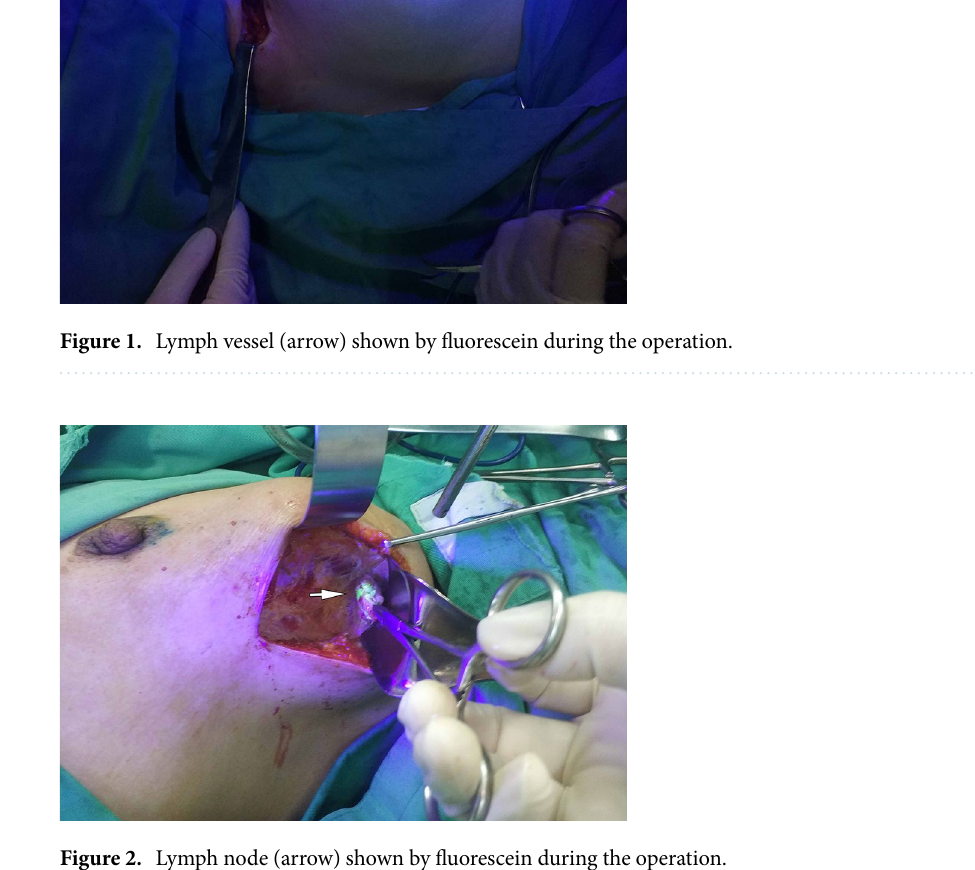
Figure 2. Lymph node (arrow) shown by fluorescein during the operation.